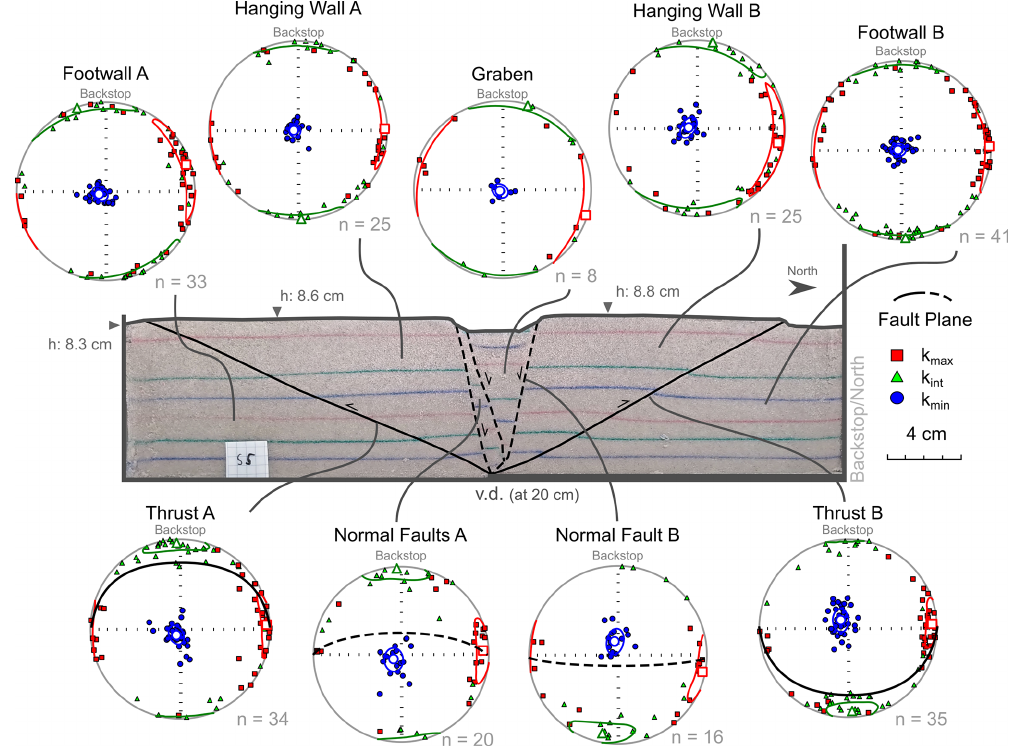
Figure 4. Representative section of Model II showing extensional and compressional structures. The magnetic fabric of each structure/area is plotted on equal-area lower-hemisphere projections with confidence ellipses and mean of each principal